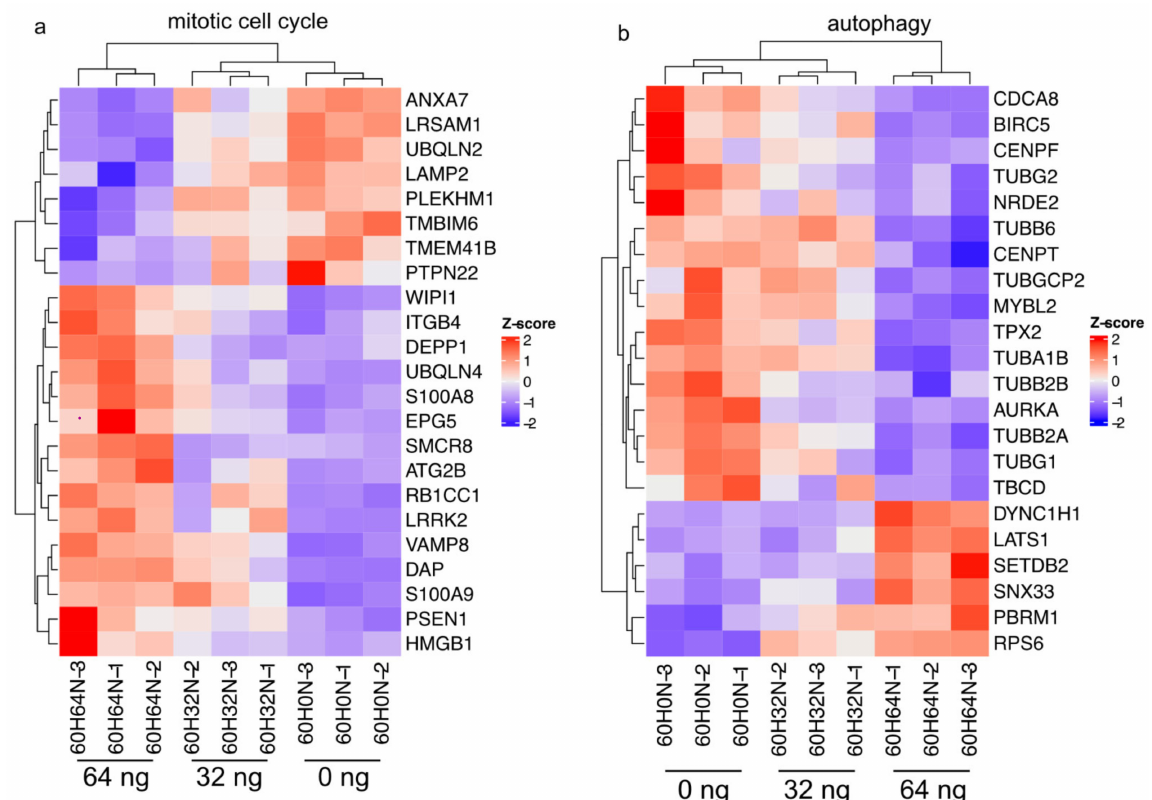
Figure 5. Effect of everolimus treatment on cell cycle and autophagy. ( a ) Heatmap illustrating RNA-Seq differential expression for genes associated with mitotic cell cycle (GO:0000278, padj < 0.01). ( b ) Heatmap illustrating RNA-Seq differential expression for genes associated with autophagy (GO:0006914, padj < 0.01) after 60